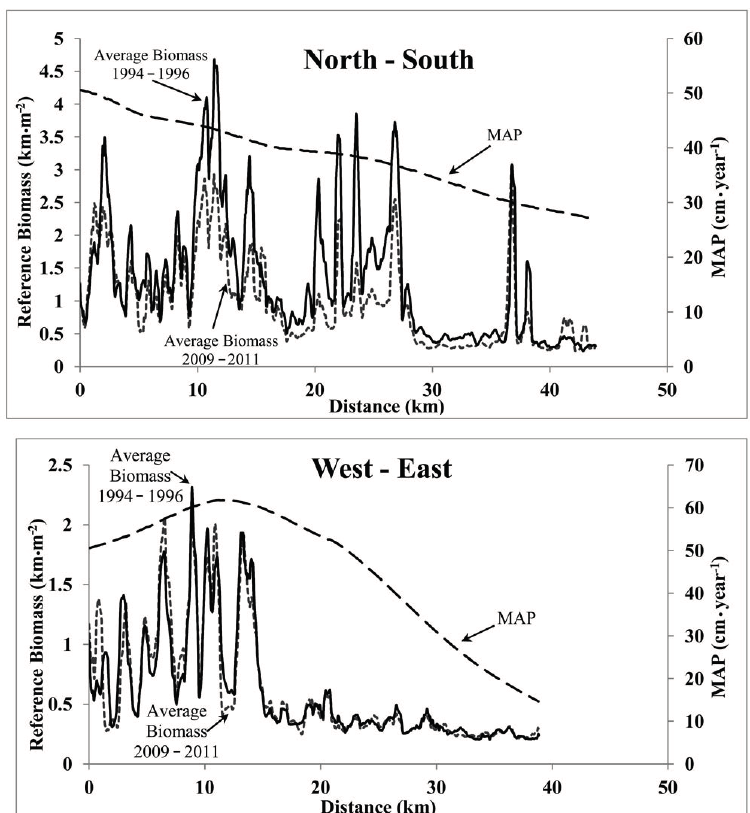
Figure 11. Cross sections of biomass (Figure 10) and MAP: From the Jerusalem Mountains (Bet-Shemesh) eastwards to the Judean Desert and from the Jerusalem Mountains southwards towards the Negev